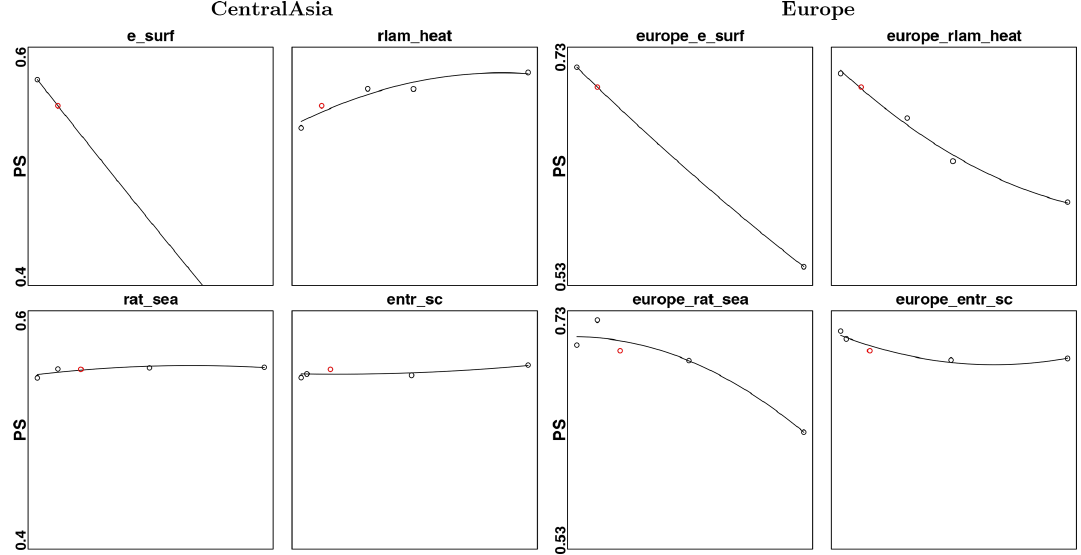
Figure 11. PS values calculated for Central Asia (left) and Europe (right), for different values of the parameters e_surf , rlam_heat , rat_sea and entr_sc . The values of the parameters are the same in the two cases. Red dots correspond to the PS values obtained for the default